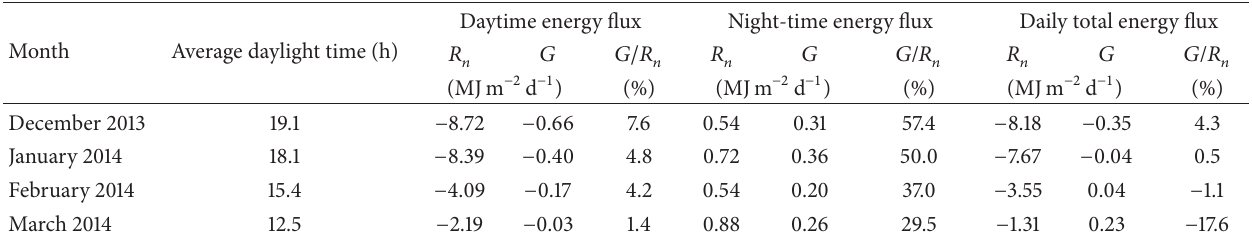
Table 1: Summary of daily energy fluxes ( 𝑅 𝑛 and 𝐺 ), partitioned into daytime, night-time, and daily fluxes.